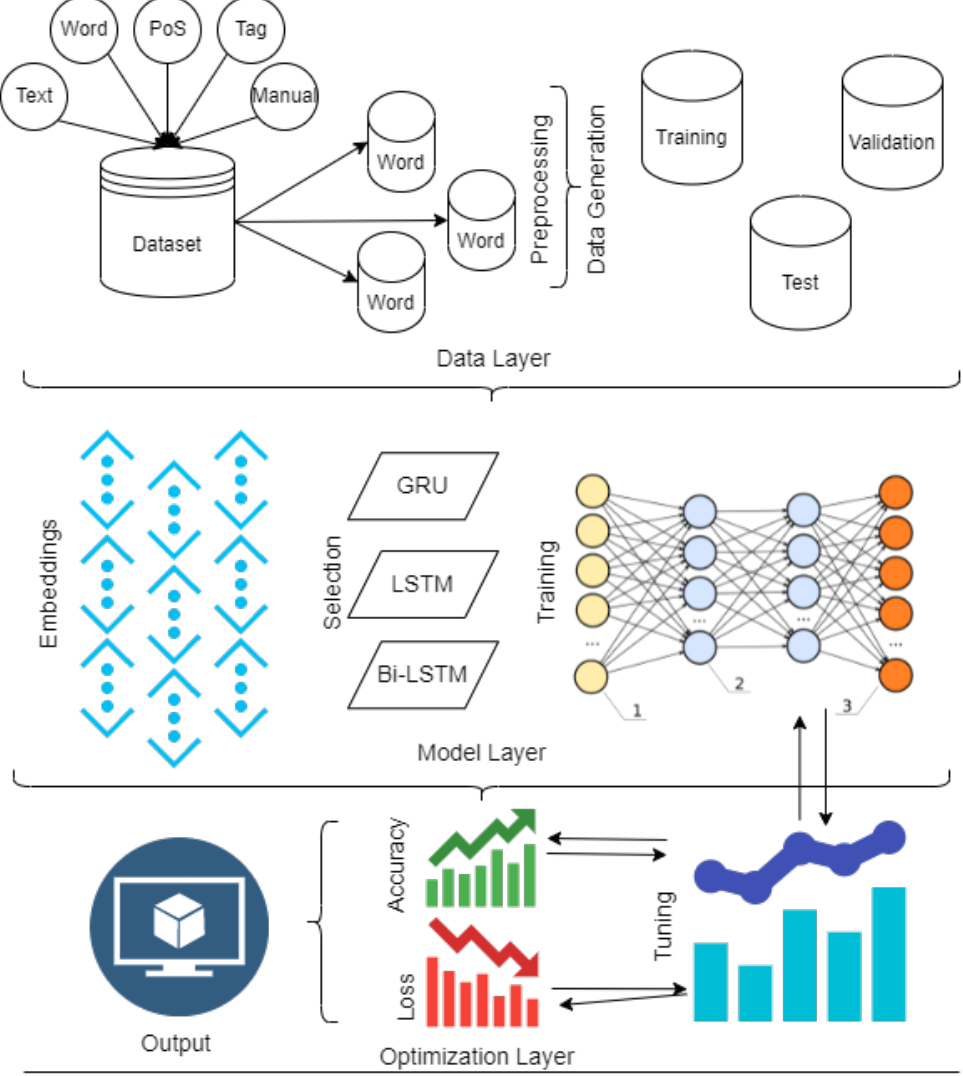
Figure 3. Architectural diagram of the proposed approach illustrating the: ( Top ), Data Layer ( Middle ), Model Layer ( Bottom ), Optimization